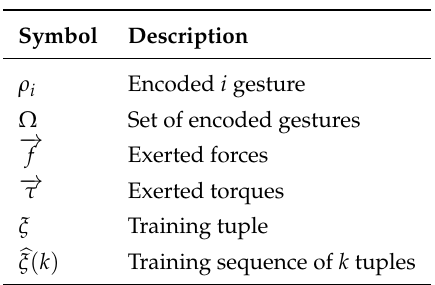
Figure 2. Method for gesture recognition and haptic guidance based on learning from demonstration. A unique library is used to detect the current gesture and provide the haptic guidance to the operator. Table 1.